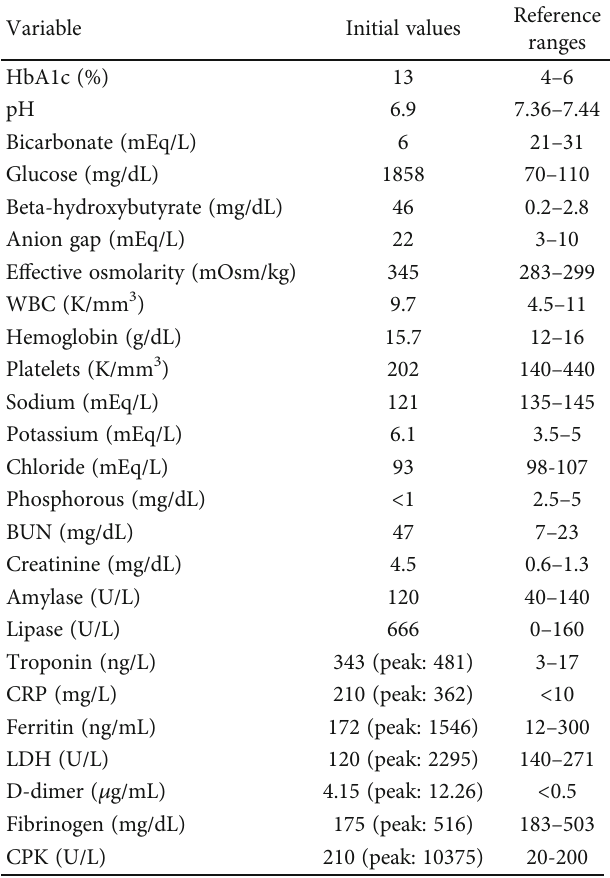
Table 1: Initial laboratory values and peaked values for the in fl ammatory markers.